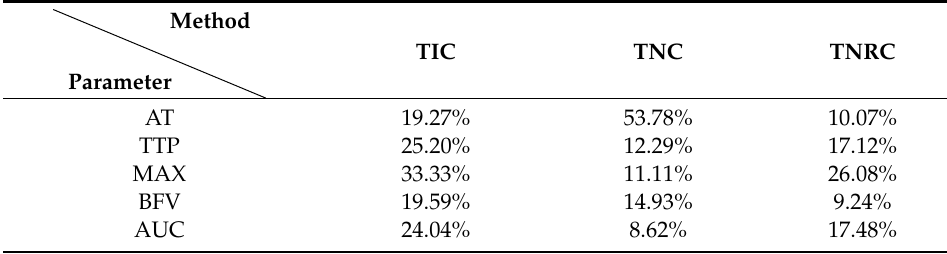
Figure 13. The comparison of ( a ) arrival time, ( b ) time-to-peak, and ( c ) blood flow velocity estimated from TIC, TNC, and TNRC (N = 20, **: p < 0.01, data were presented as mean ± standard deviation). Table 3. Relative standard deviation (RSD) of perfusion parameters estimated from di ff erent time curves of contrast-enhanced ultrasound (CEUS)